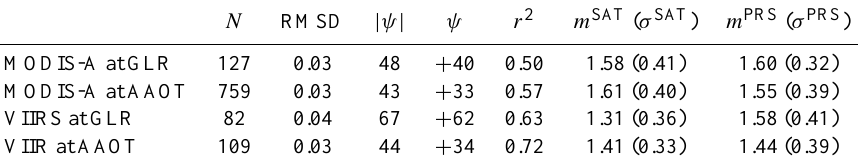
Table 2. Results from the analysis of satellite (SAT) and AERONET-OC (PRS) τ a match-ups at 869 nm for MODIS-A or 862nm for VIIRS, at the GLR and AAOT sites. N indicates the number of match-ups, RMSD is the root mean of squared differences, and | ψ | is the mean of absolute percent differences, while ψ is the mean of percent differences, and r 2 is the determination coefficient. The symbols m SAT , m PRS , σ SAT and σ PRS indicate the median and standard deviation, respectively, of the α values determined for satellite data (i.e., SAT) with τ a at 443 and 869nm for MODIS-A, with τ a from 443 to 862nm for VIIRS, and at equivalent wavelengths for AERONET-OC data (i.e., PRS). N RMSD | ψ | ψ r 2 m SAT ( σ SAT ) m PRS ( σ PRS ) MODIS-A at GLR 127